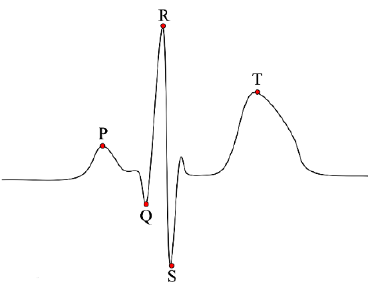
Figure 1. The basic waveform of electrocardiograms (ECG) with five fiducial points.